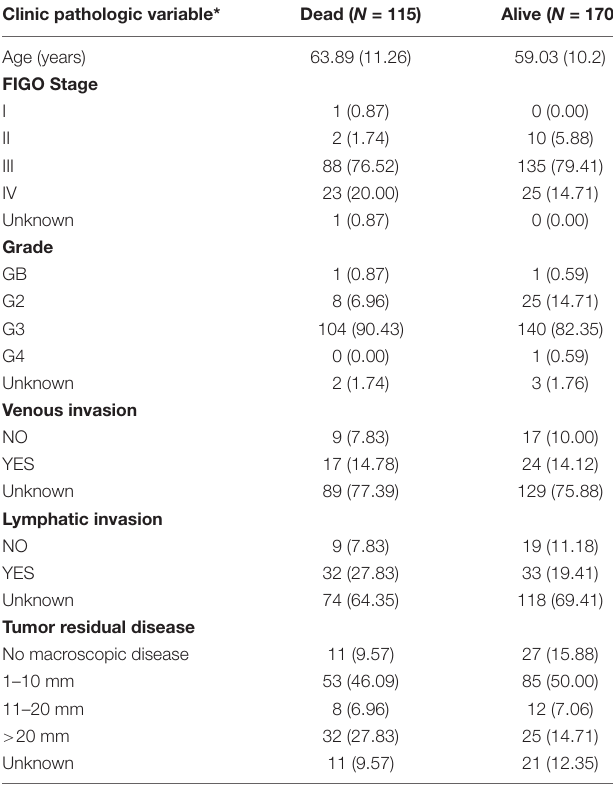
TABLE 1 | Description of clinic pathologic factors for 285 ovarian cancer patients from TCGA. Clinic pathologic